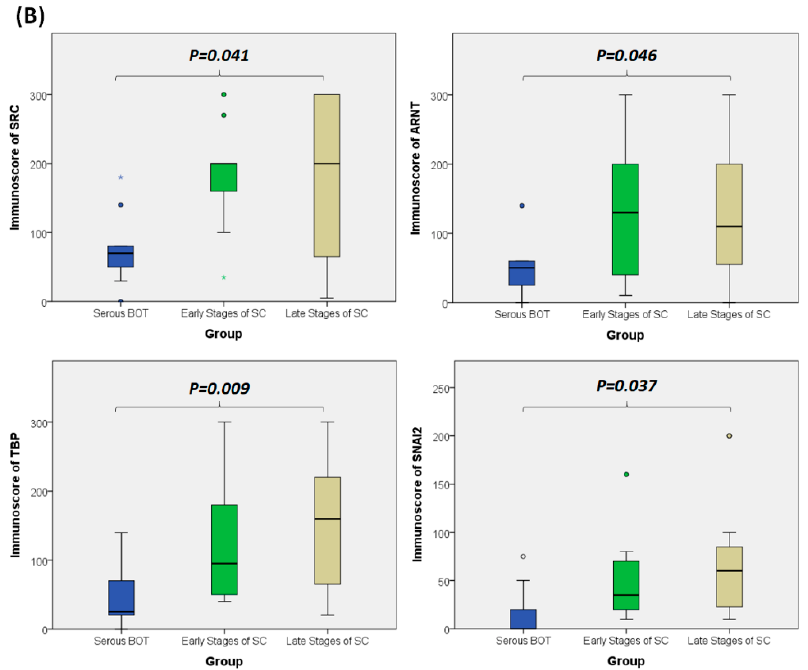
Figure 4. Verified analysis of biomarkers among serous ovarian tumors by IHC staining. ( A ) Clinical samples from patients with serous BOTs (n = 9, left column), early stages of serous ovarian carcinomas (n = 10, middle column), and late stages of serous ovarian carcinomas (n = 31, right column) were immunostained with hematoxylin and eosin (first row), anti-SRC antibody (second row), anti-ARNT antibody (third row), anti-TBP antibody (fourth row), and anti-SNAI2 antibody (fifth row). ( B ) Box plots for expressed biomarkers including SRC, ARNT, TBP, and SNAI2 among groups of serous BOTs (blue), early stages of serous ovarian carcinomas (green), and late stages of serous ovarian carcinomas (light brown). All the expression levels of these meaningful biomarkers were quantified and clearly revealed an increasing trend of mean values from serous BOTs to late stages of serous ovarian carcinomas with statistical